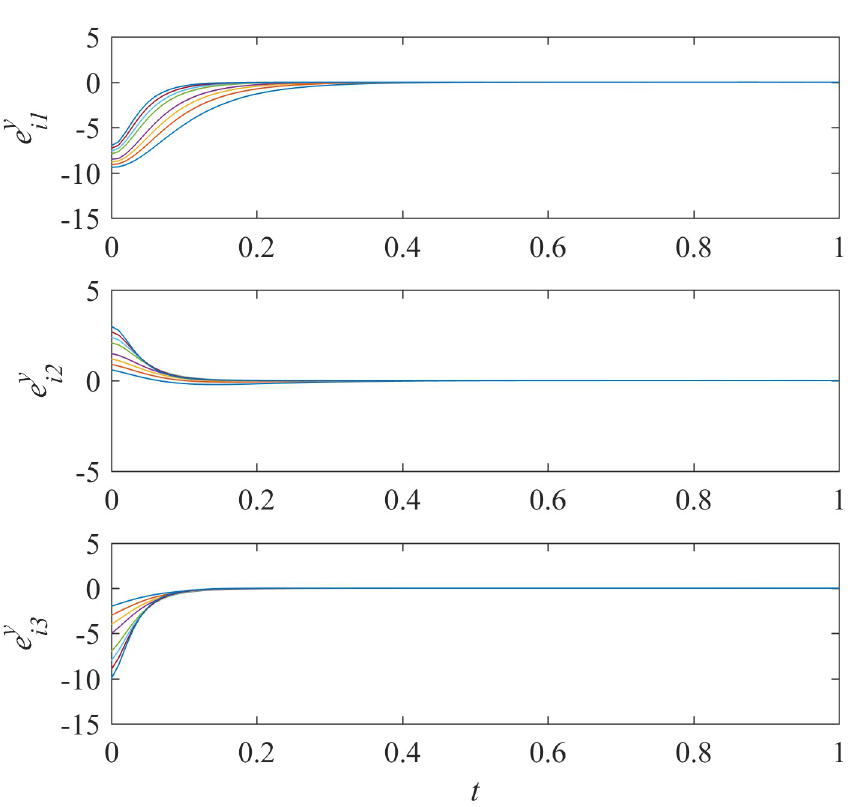
Fig 12. States of error system between the remaining nodes and the isolate node in sub-network Y while node 1 and 6 are chosen to be out of work.